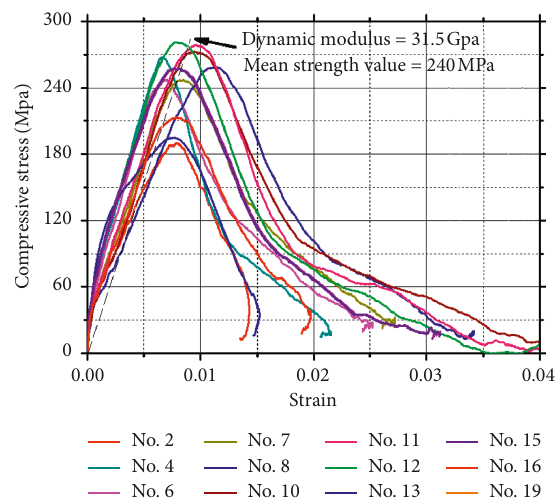
Figure 6: Dependence of the dynamic compression strength on the strain rate.